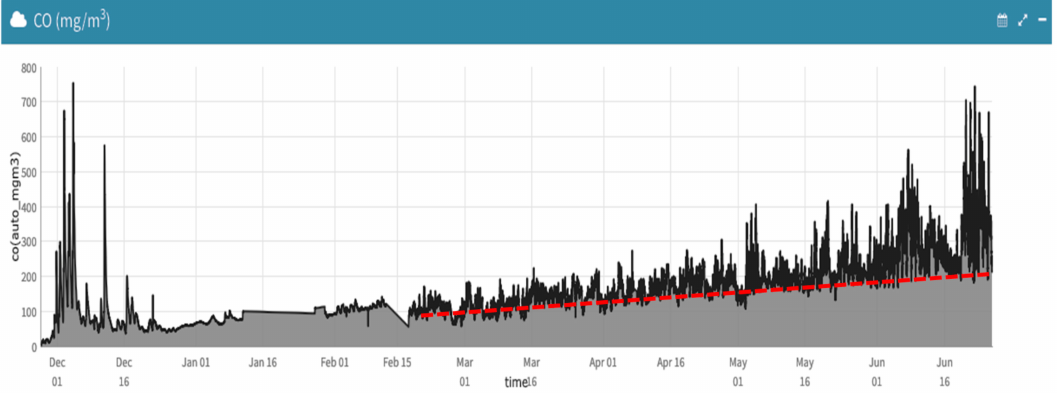
Figure 8. Evolution of CO concentration (mg/m 3 ) from December 2015 to June